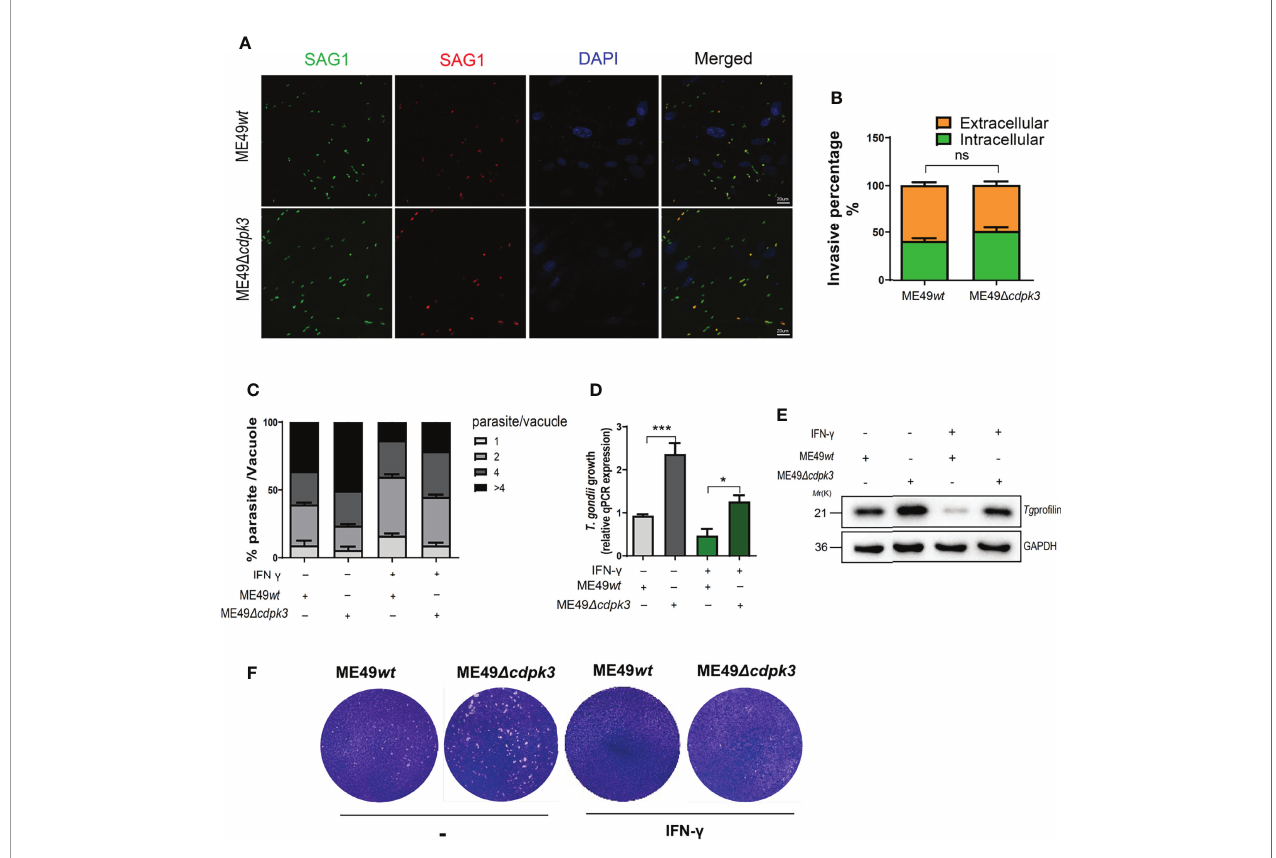
FIGURE 8 | Tg CDPK3 affects parasite growth in vitro . (A, B) ME49 wt or ME49 D cdpk3 parasites were allowed to invade con fl uent MEF cells for 2 hours. (Scale bar:20 m m). Determine the percentage of intracellular parasites. (C-E) MEF cell was stimulated with 100 U/mL IFN- g for 24 h. Following stimulation, equal mount ME49 wt or ME49 D cdpk3 parasites infected MEF cells for 24 hours. (C) A total of at least 200 vacuoles were inspected to determine the number of vacuoles containing 2, 4, 8, or 16 parasites. (D) Parasite growth was also quanti fi ed by qPCR of genomic DNA using the SAG1 primers and normalized against b -actin. (E) Total infected cell proteins at 24 hours after Toxoplasma infection were analyzed by immunoblotting to detect T. gondii pro fi lin protein. GAPDH was used as a loading control. (F) Plaque assay comparing the growth of ME49 wt or ME49 D cdpk3 parasites. Data are mean ± SD of triplicates. Statistical differences are represented by ***p < 0.001, *p < 0.05, ns, no signi fi cant (n=3 each